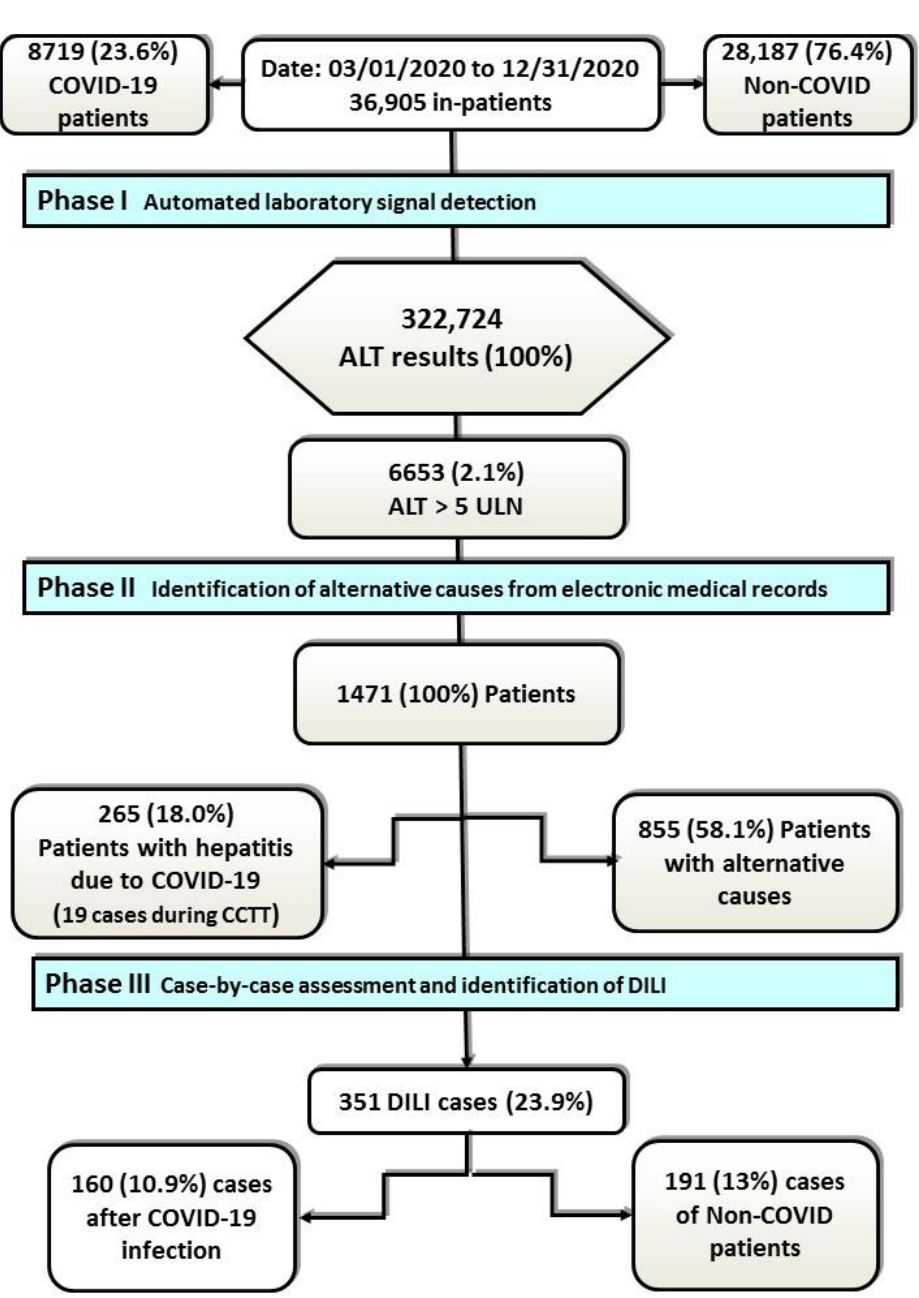
Figure 1. Flowchart. Abbreviations: ALT, alanine aminotransferase; DILI, drug-induced liver injury; CCTT, clinical trials; ULN, upper limit of normal.